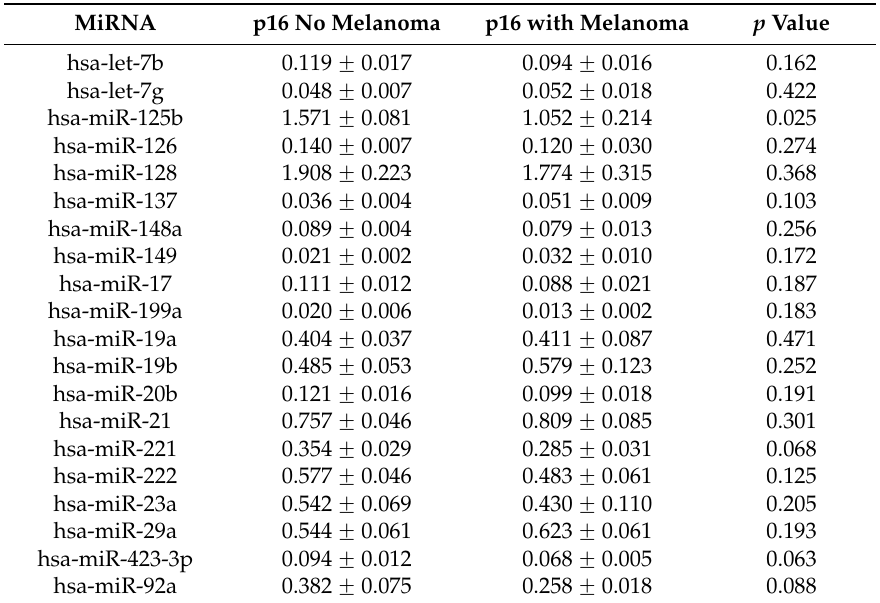
MiRNA expression in plasma-derived exosomes from p16 mutation carriers with or without melanoma.